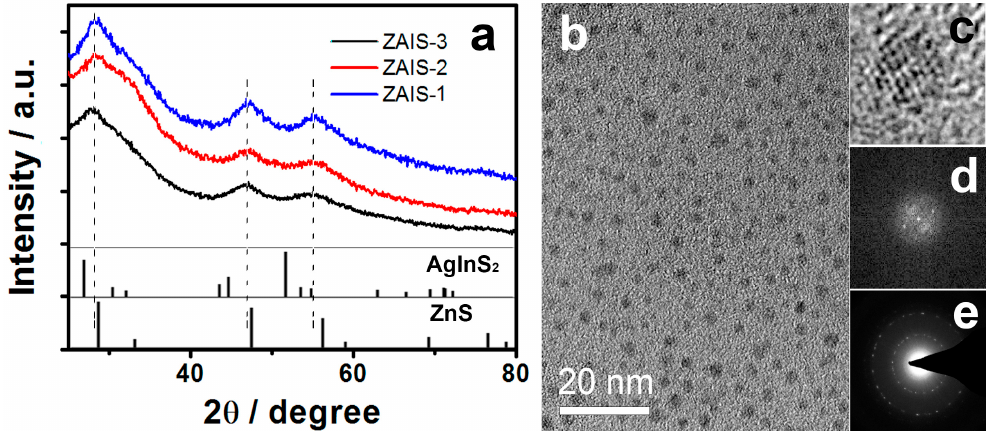
Figure 1. ( a ) X-ray powder diffraction (XRD) patterns of Zn x Ag y InS 1.5+x+0.5y nanocrystals (ZAIS NCs) (ZAIS-1, ZAIS-2, and ZAIS-3), ( b ) transmission electron microscope (TEM), ( c ) high-resolution transmission electron microscope (HRTEM) micrograph, ( d ) corresponding inverse fast fourier transform (FFT) pattern, and ( e ) energy dispersive X-ray spectrometry (EDX) analysis of ZAIS-2. The XRD patterns of AgInS 2 (JCPDS 25-1330) and ZnS (JCPDS 65-1691) are shown as reference.